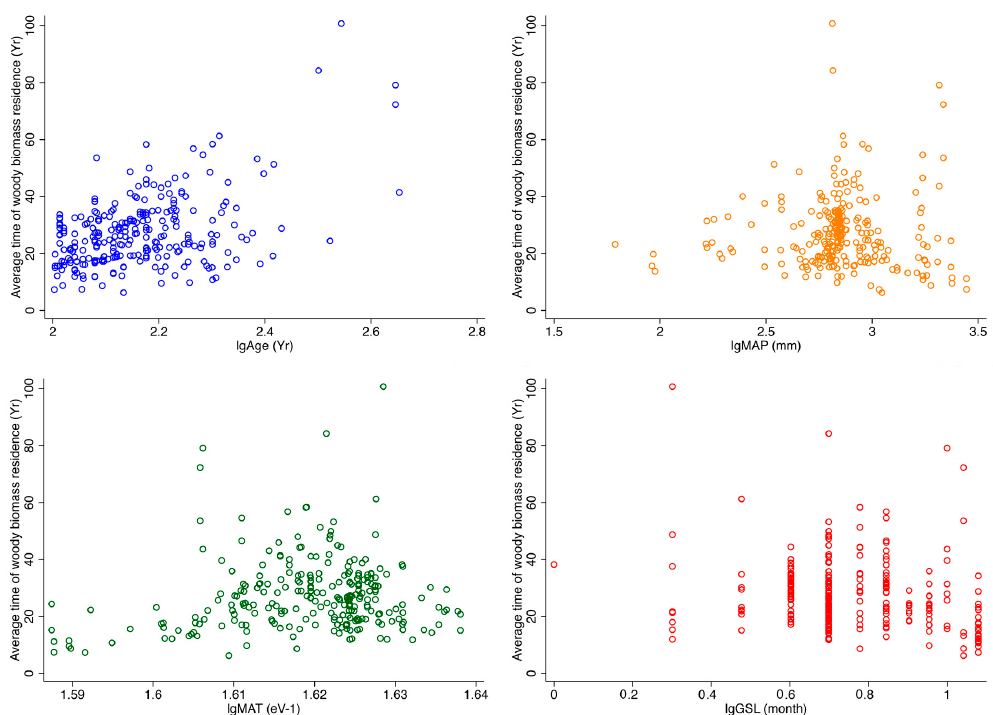
Figure 2. Variation in average time of woody biomass residence for 262 woody plant communities. Age: Forest age, year; GSL: Growing season length, month; MAP: Mean annual precipitation, mm; MAT: Mean annual temperature, eV − 1 . The variables were transformed by Log10 (lg).